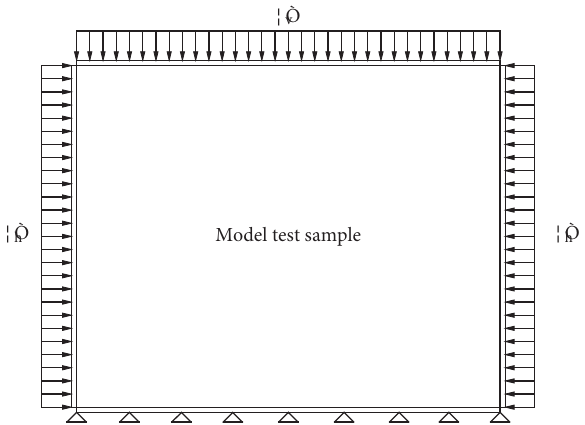
Figure 2: The loading diagram for the test sample.